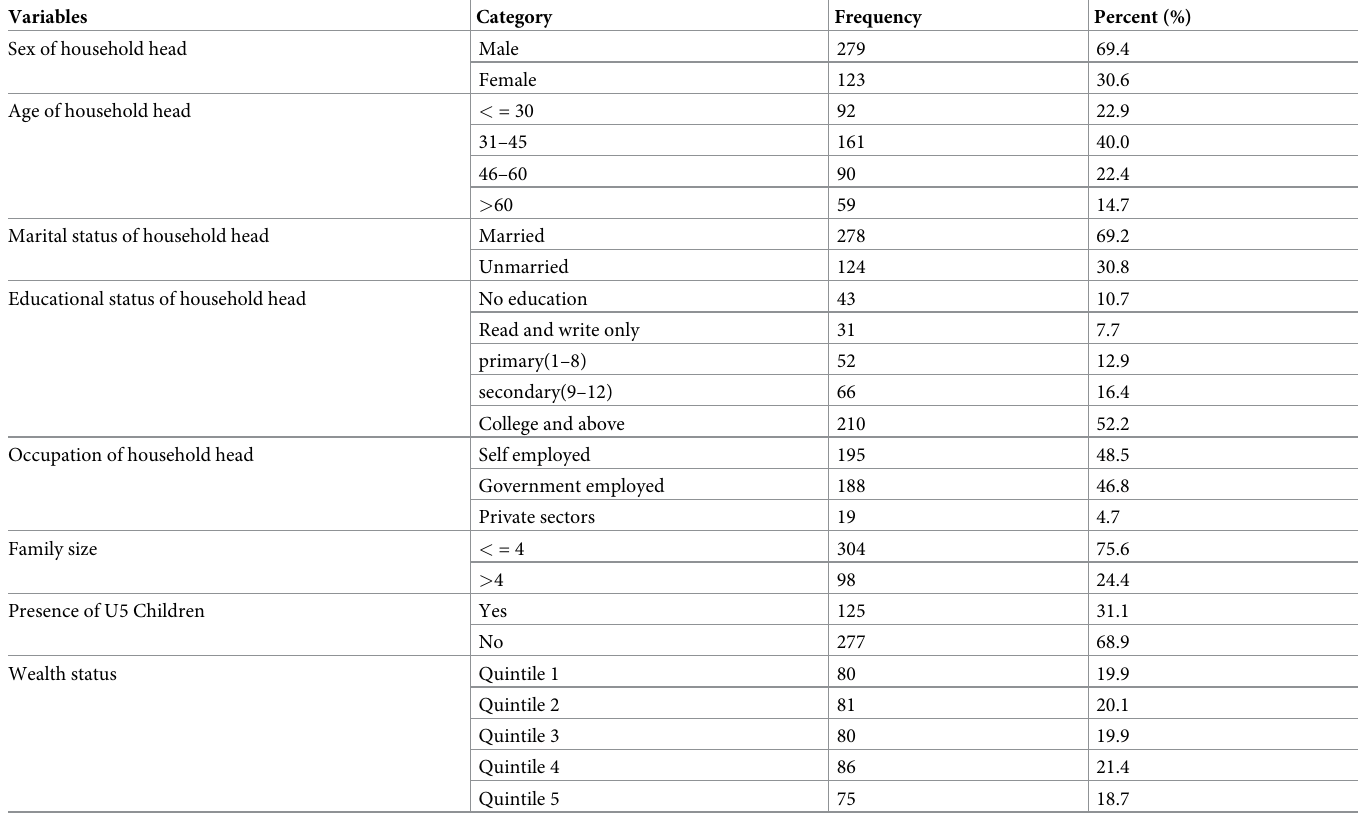
Table 1. Sociodemographic and socioeconomic characteristics of households, Debre Tabor town, Ethiopia, 2022.